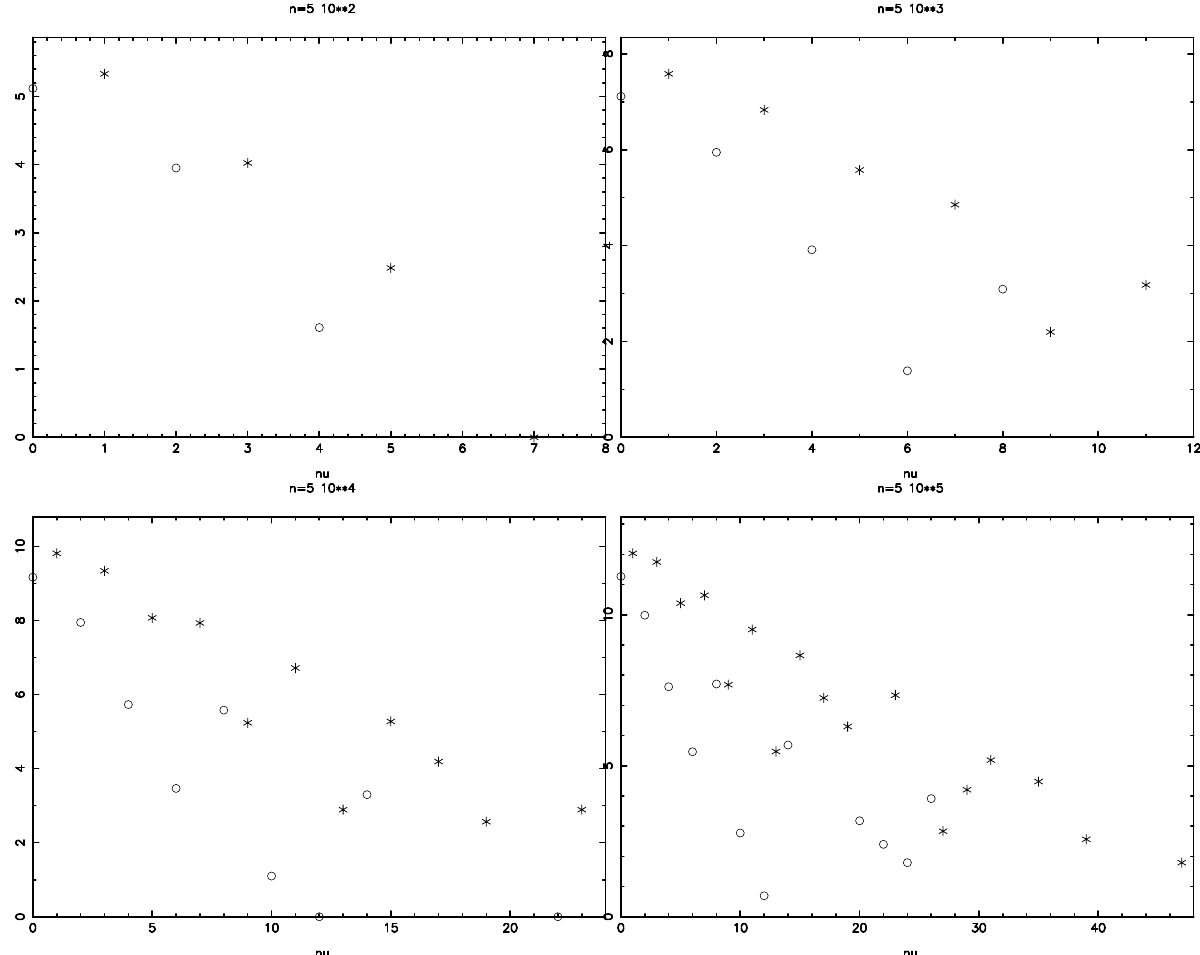
( ν ) vs. ν for n = 5 10 2 , 5 10 3 5 10 4 , 5 10 5 . Circle: n